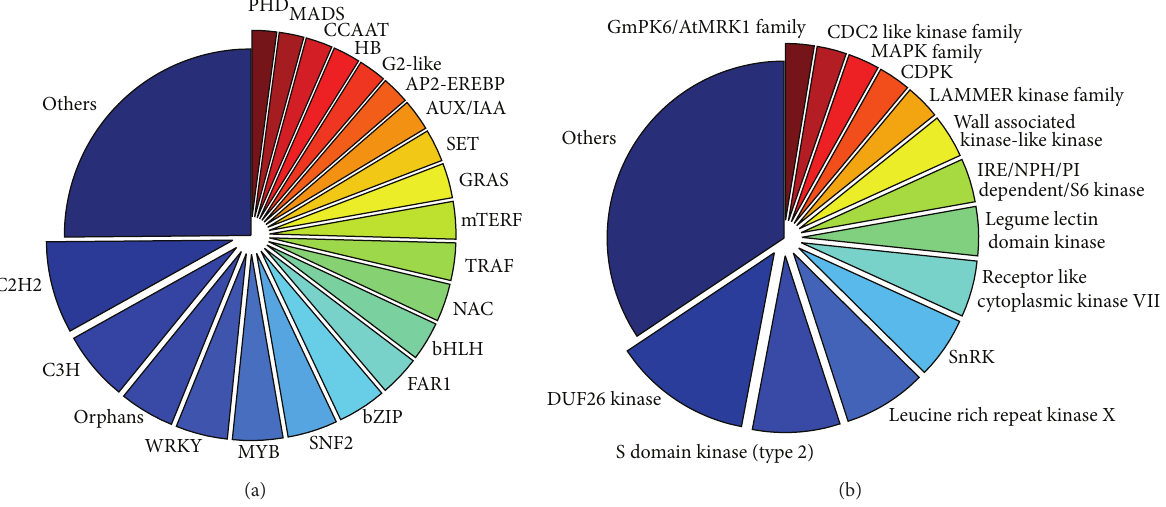
Figure 3: Number of unique transcripts classified as transcription factor and protein kinase gene transcripts in Thinopyrum elongatum . (a) Transcription factor gene transcripts. (b) Protein kinase gene